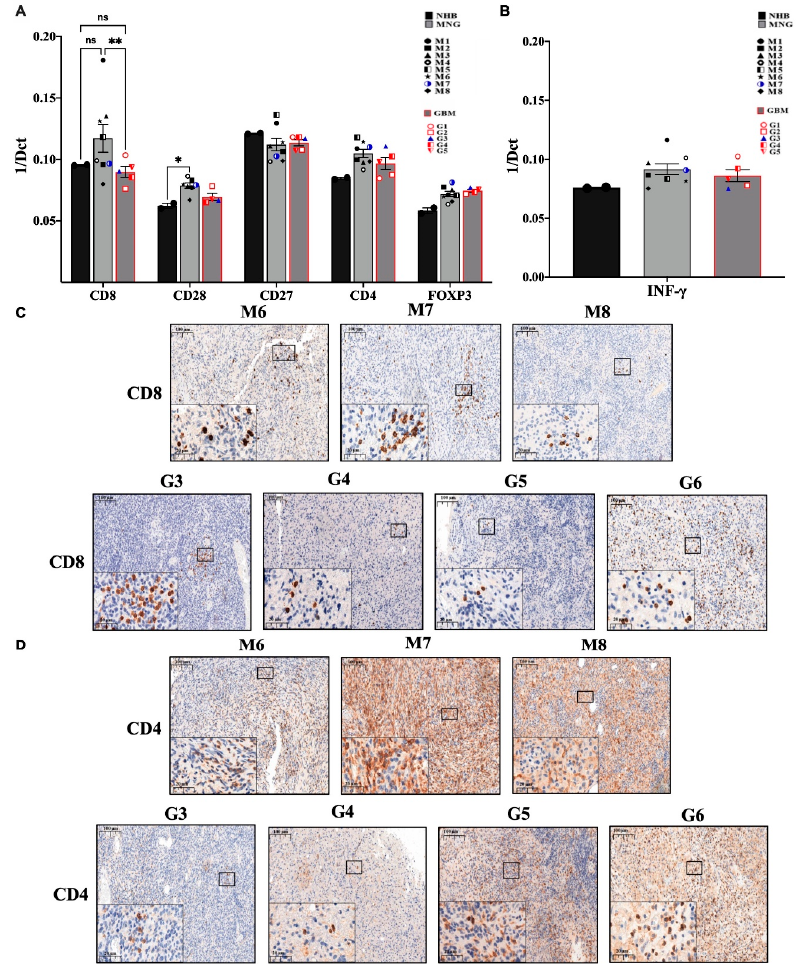
Figure 2. Evaluation of the immune profile of MNG and GBM. ( A ) mRNA expression levels of CD8 cytotoxic T-cells and CD4 T-helper cells, CD28 as costimulatory signal transducer for T-cells survival and activation, as well as FOXP3 marker characteristic for regulatory T cells. ( B ) The anti-tumor interferon-gamma (INF- γ ) mRNA expression levels were evaluated in both brain tumor microenvironments. Data are presented 1/dCt individually and as average ± SEM. Significant changes are marked as * and ** ( p < 0.05 and p < 0.001, respectively). ( C ) Immunohistochemistry staining of CD8 was performed in MNG ( n = 3) and GBM ( n = 4) samples, magnification × 20 and × 40, size bar 100 and 20 µ m respectively. ( D ) Immunohistochemistry staining of CD4 cells in MNG and GBM, magnification × 20 and × 40, size bar 100 and 20 µ m